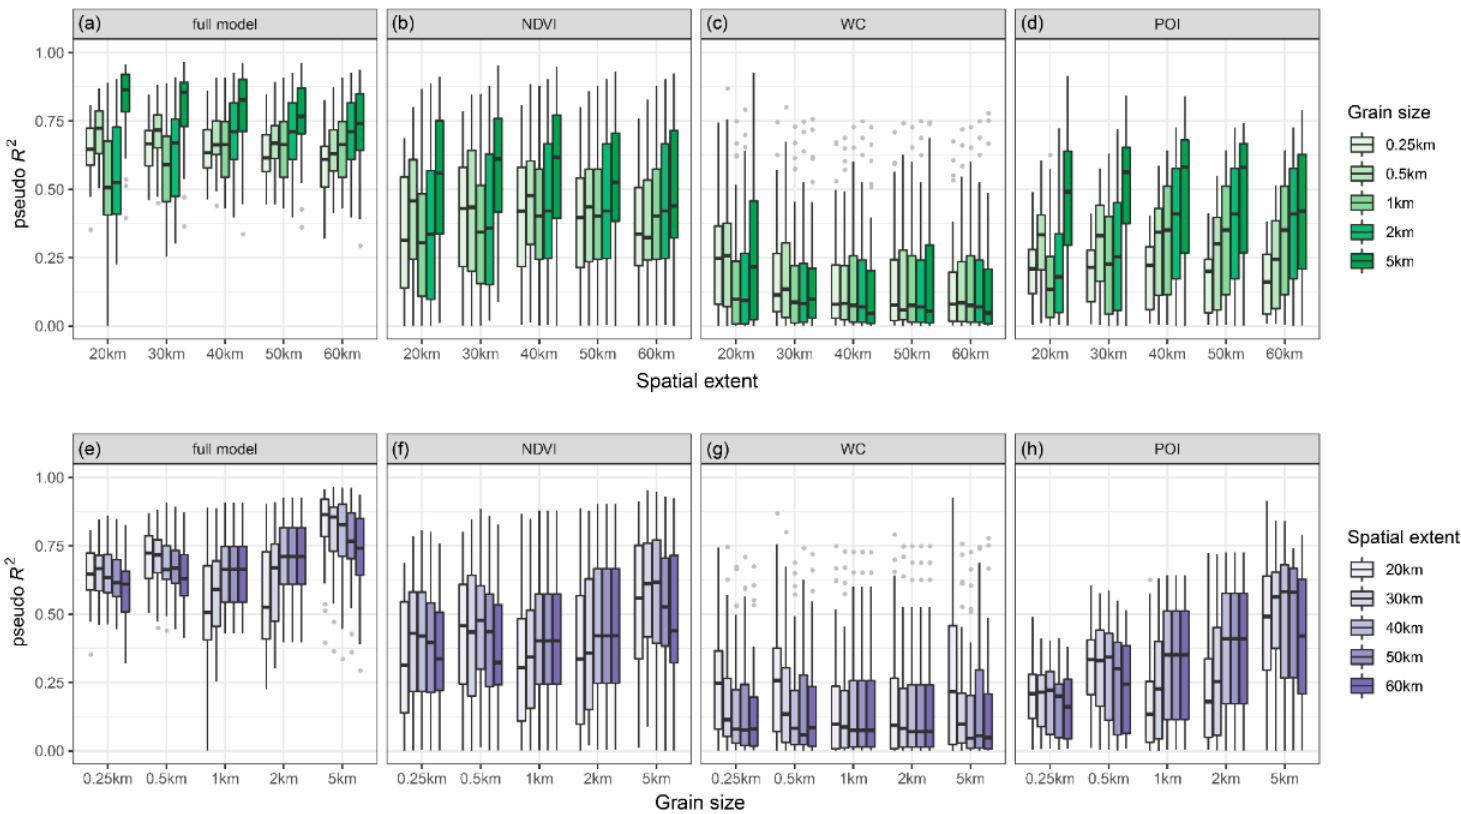
Figure A19. The power (pseudo R 2 , the non-spatial component of simultaneous autoregressive) of NDVI, WC and POI density explaining the LST patterns across the grain size from 0.25 km to 5 km (at each fixed spatial extent, upper panels) and the spatial extent range from 20 to 60 km (at each fixed grain size, lower panels).